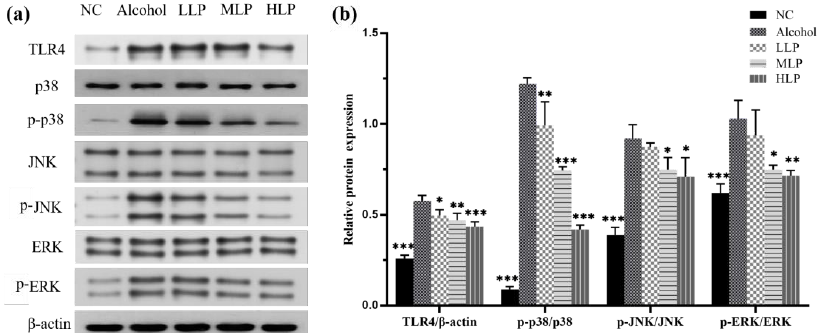
Figure 7. Effects of L. plantarum J26 on the expression of related gene proteins in TLR4 and MAPK signaling pathways. ( a ): the expression of TLR4, p38, p-p38, JNK, p-JNK, ERK, p-ERK protein in the liver; ( b ): Relative expression of each protein. NC, normal control; LLP, low-dose L. plantarum J26; MLP, medium-dose L. plantarum J26; HLP, high-dose L. plantarum J26. The data were analyzed with a one-way ANOVA and expressed as means ± SD ( n = 3). * p < 0.05, ** p < 0.01 and *** p < 0.001 compared with the Alcohol group.